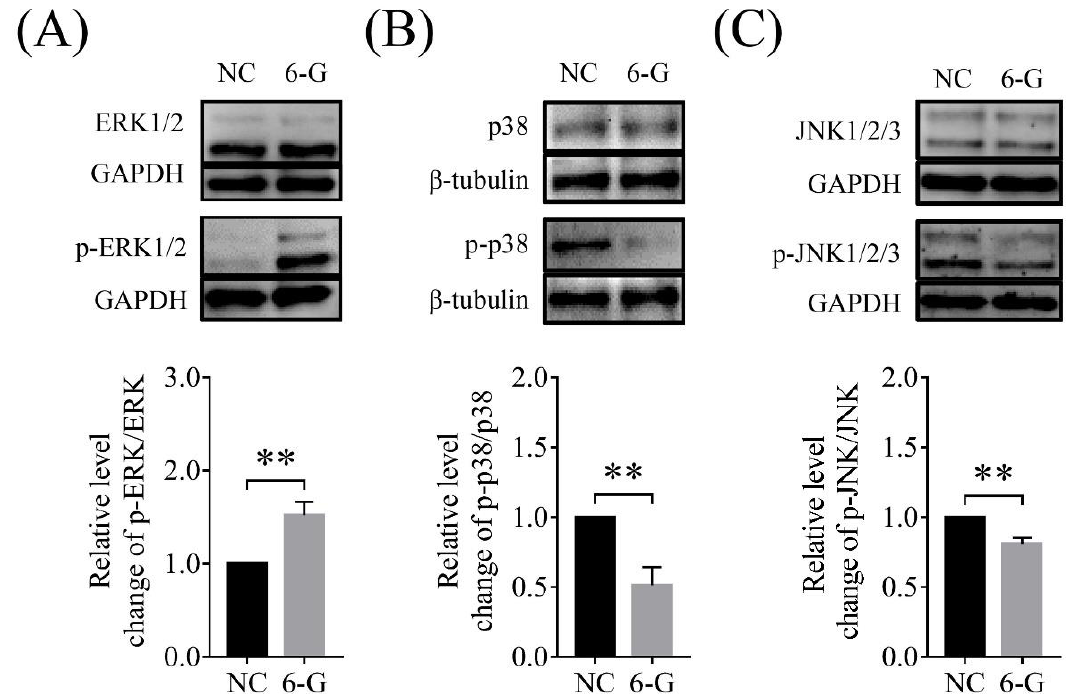
Figure 8. Effects of 6-gingerol (6-G) on the extracellular regulated protein kinase 1/2 (ERK1/2), c-Jun N-terminal kinase 1/2/3 (JNK1/2/3), and p38 pathways. ( A ) The level of p-ERK1/2 in the 6-G treatment group was higher than that of the NC group. R = 3. ( B ) The level of p-p38 in the 6-G treatment group was lower than that of the NC group. R = 3. ( C ) The level of p-JNK1/2/3 in the 6-G treatment group was lower than that of the NC group. R = 3. ** p < 0.01.